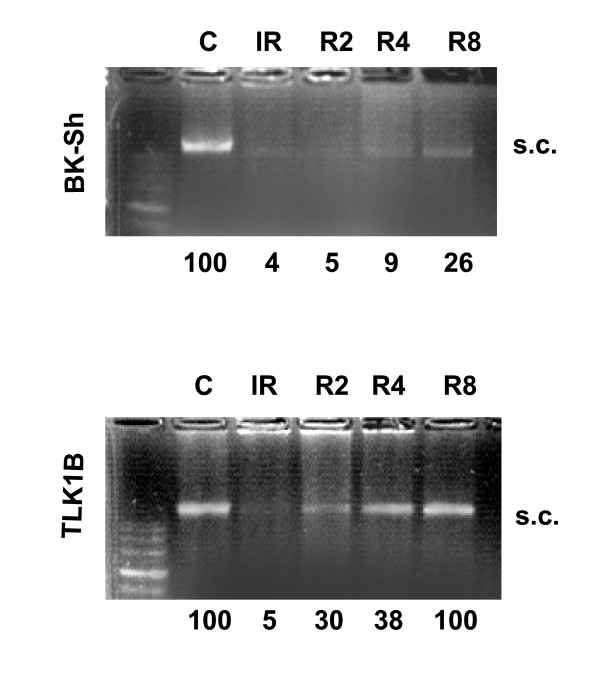
Analysis of episomes during a time course of recovery from IR. 2 × 107 cells transformed with BK-Shuttle or TLK1B were irradiated (or not, C) with 20 Gy of γ-radiation. The cells were returned to the incubator and the plasmids were isolated immediately after radiation (IR), or after the indicated times of recovery, 2 to 8 hr (R2-R8). The episomes were recovered by alkaline lysis, which removes plasmids with DSBs by strand separation followed by the rapid renaturation. This is because it is not always easy to separate on agarose gels the linearized from the supercoiled form of the plasmid (these plasmids are 11–14 kb in size, without and with insert). The bands were quantified with ImageQuant. The intensities of the bands relative to control are indicated underneath each lane. Size markers (Novagen 1 kb ladder) are shown in the first lane.